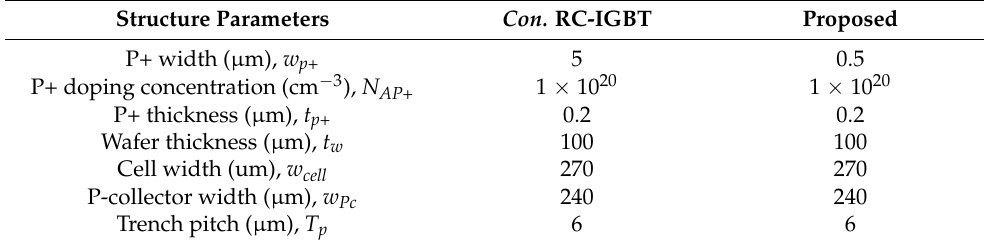
Table 1. Device Table 1. Device speci fi cations.